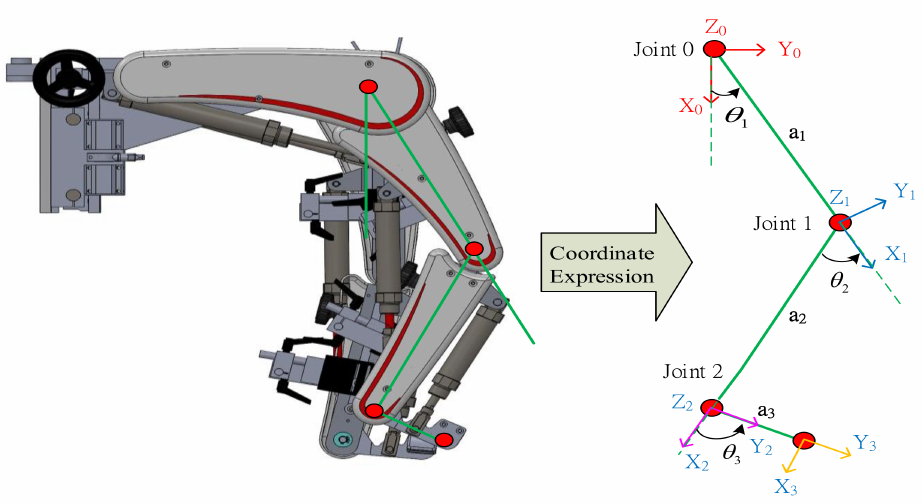
Figure 6. Coordinate system of the lower